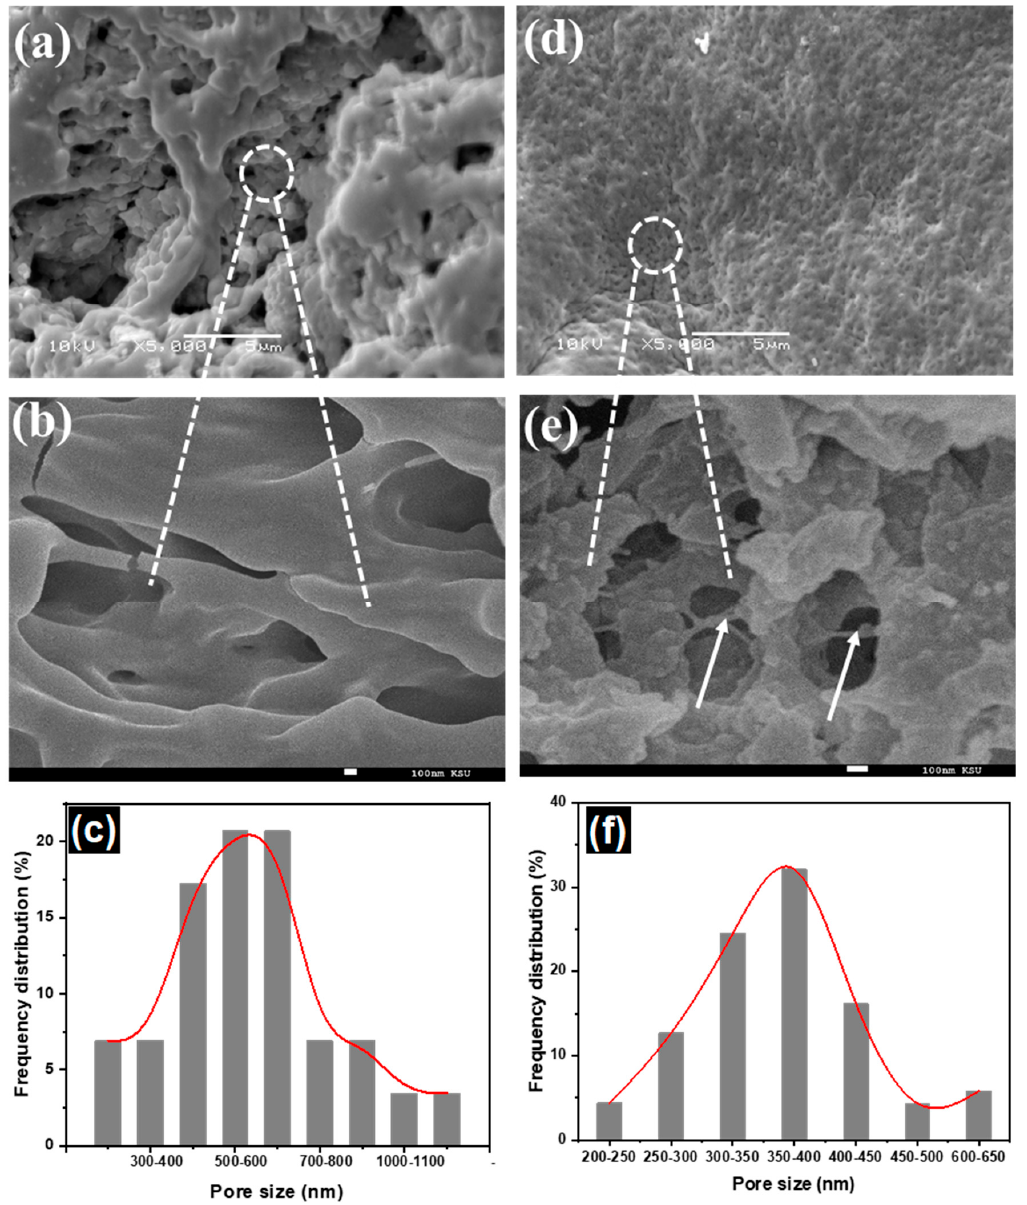
Figure 1. SEM images low and high magnification of ( a , b ) chitosan-grafted-polyacrylic (CT- g -PAA) hydrogel, ( d , e ) chitosan - grafted-polyacrylic acid/oxidized electrospun carbon nanofibers (CT- g -PAA/O-ECNFs)-0.5 hydrogel nanocomposite, and pore size distribution of ( c ) CT- g -PAA hydrogel and ( f ) CT- g -PAA/O-ECNFs-0.5% hydrogel nanocomposite.